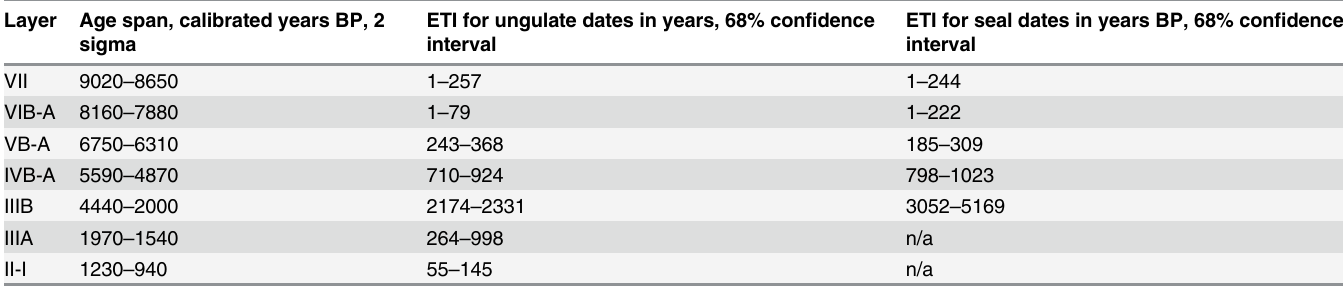
ETI is estimated time interval calculated (where possible) from multiple radiocarbon dates from each